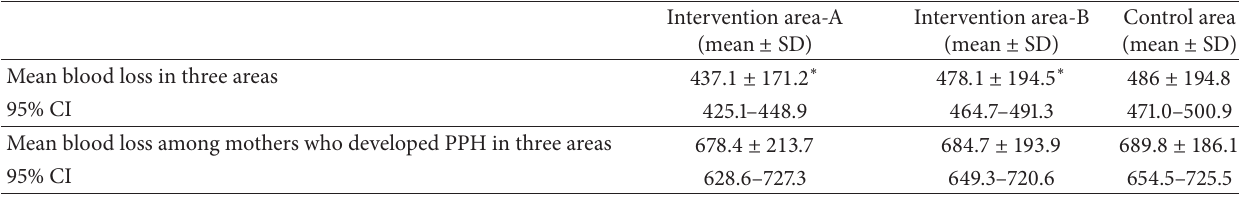
Table 5: Assessments on amount of blood loss after childbirth.